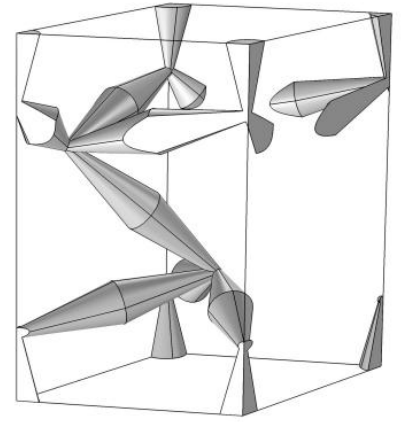
Figure 11. The primitive cell with P 1 and P 2 moving in opposite directions horizontally. The structural and geometric parameters also affect the band gaps, as shown in Figure 12. The effects of η c on the band gap are shown in Figure 12a with d = 0.02 l , D = 0.1 l , and θ = 0. Compared with Figure 10a, smaller η c can lead to band gaps and the average band width is larger. The performance of the primitive cell with P 1 and P 2 moving in opposite directions is much better than only moving one of them. By exploring the band gaps with θ when η c = 0.4, the band gaps change little with θ , as shown in Figure 12b. The relationships of band gaps with d and D are shown in Figure 12c,d, which are similar to the pentamode band in Figure 4. The parameter η c = 0.35 for both cases, D = 0.1 l for Figure 12c, and d = 0.02 l for Figure 12d. Too large and too small d or D values both narrow the band width of the gap. Proper values of d and D need to be explored if a wide band gap is